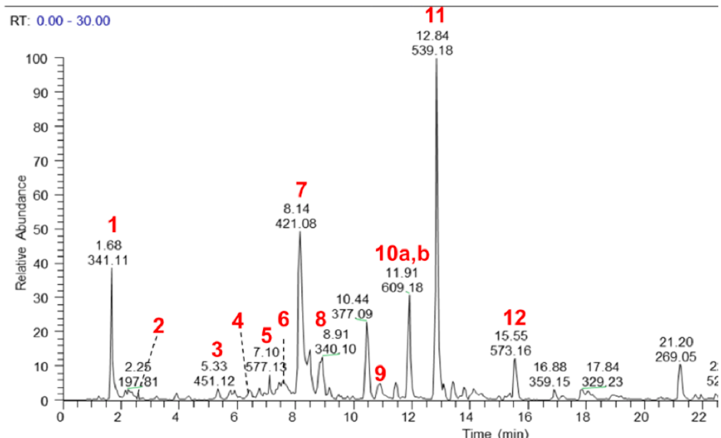
Figure 1. LC–MS base peak chromatogram (negative ionisation mode) of a MeOH extract of CareVid. For compound identities, refer to Section 2.1 or Table S1 in Supplementary Files.